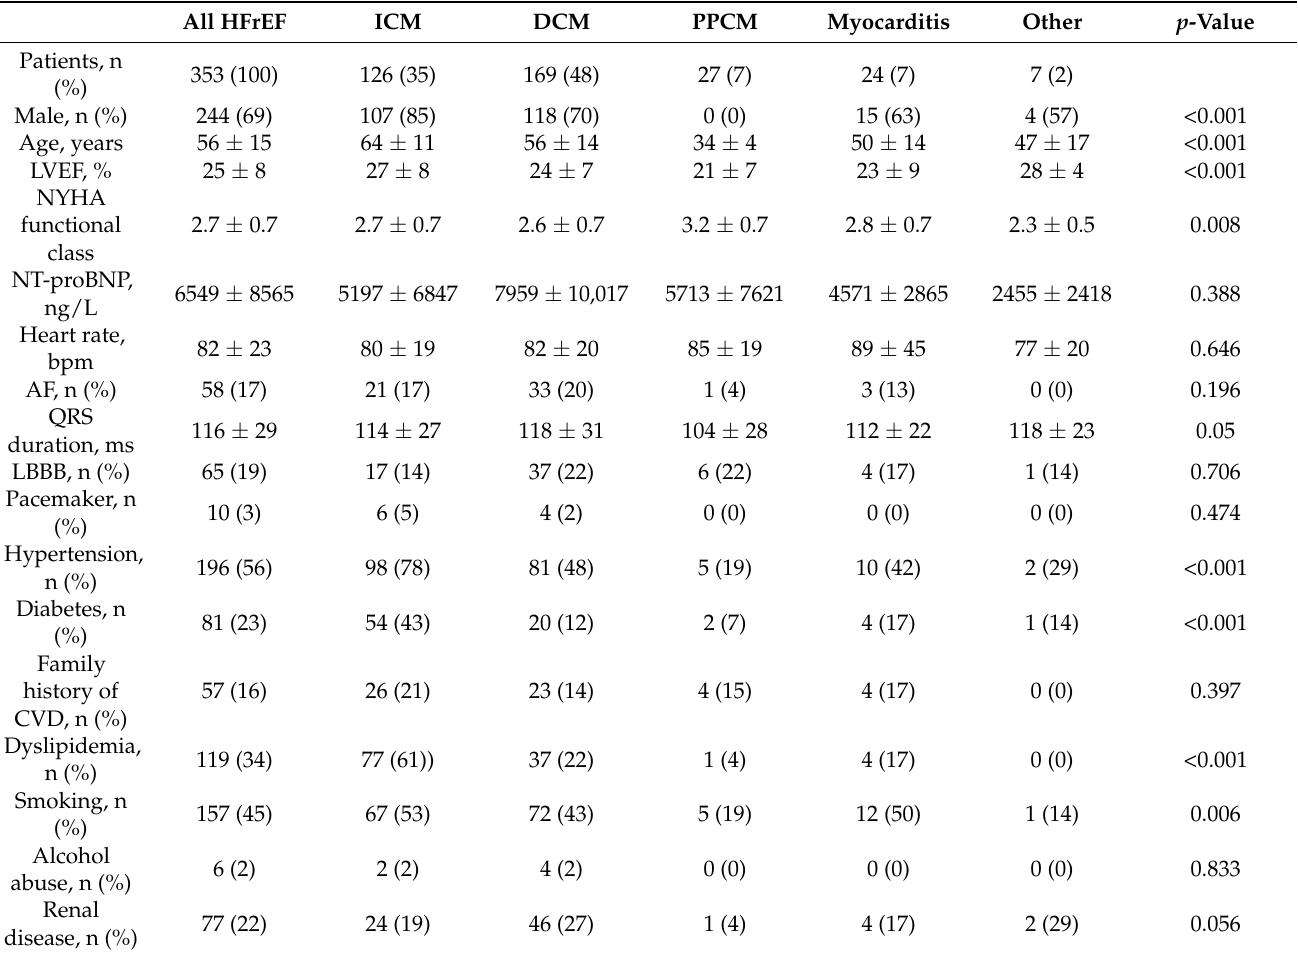
Table 1. Baseline characteristics of different HFrEF